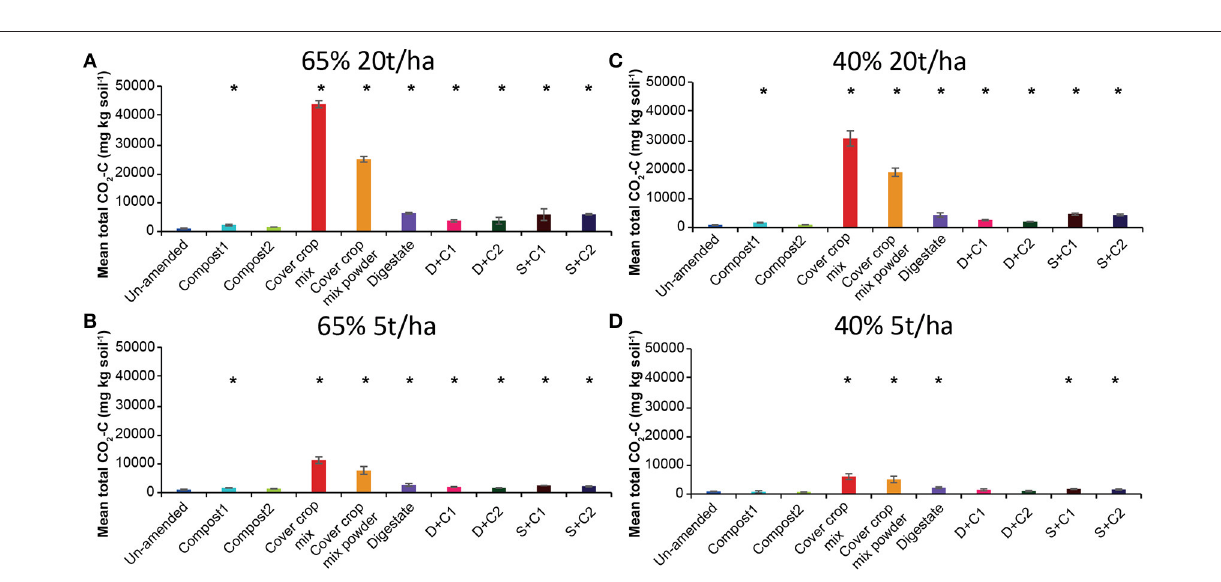
( Figure 4 ). Notably, compost1 and 2 treatments led to